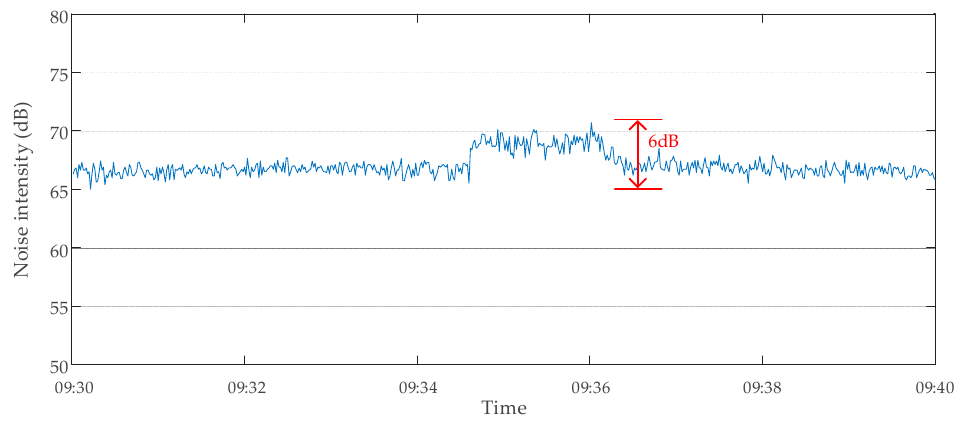
Figure 15. Monitoring data of noise intensity of transformer E on 18 October 2019. Sensors 2020 , 20 , x FOR PEER REVIEW